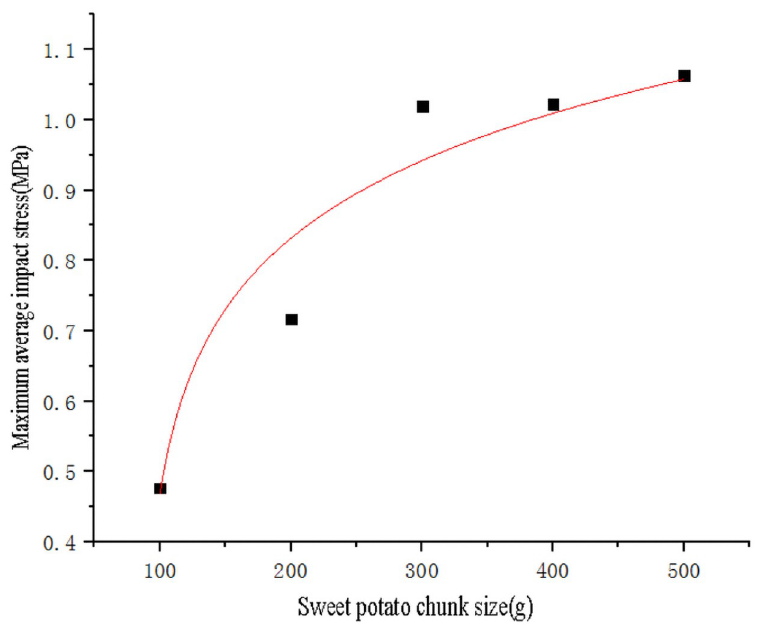
Fig 21. Fitting curve of sweet potato chunk size and impact stress.